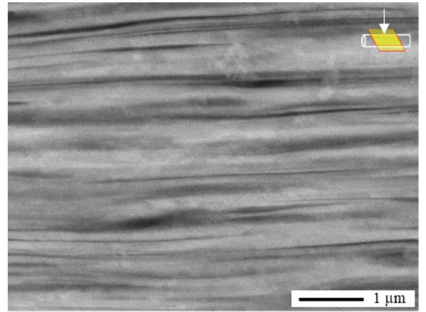
Figure 5. BSE image depicting the microstructure of the ECAPed specimen after 2nd drawing measured in the radial